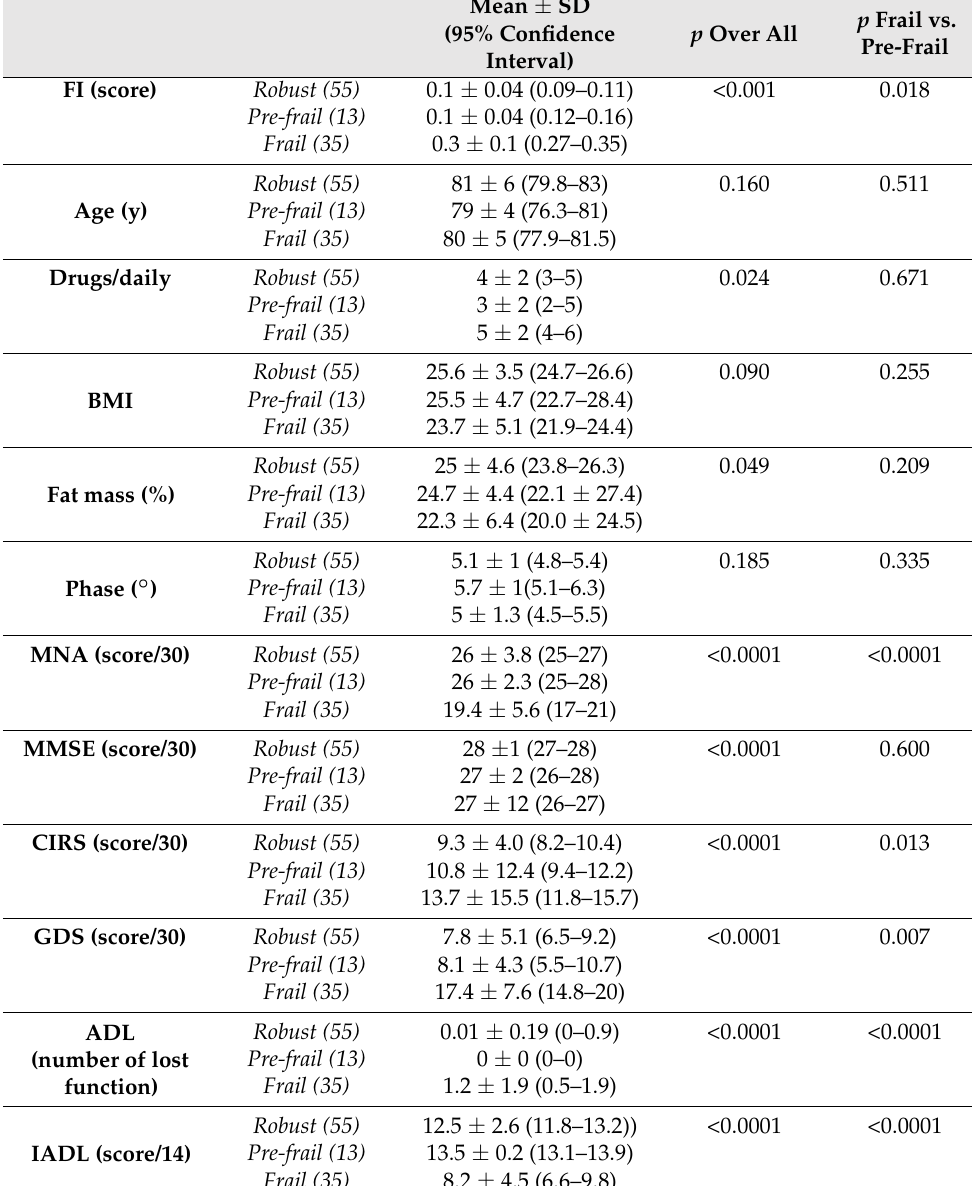
Table 1. General characteristics of the subjects classified according to the FP criteria . The mean and SD with CI are shown, and the p -values were calculated with one-way ANOVA.